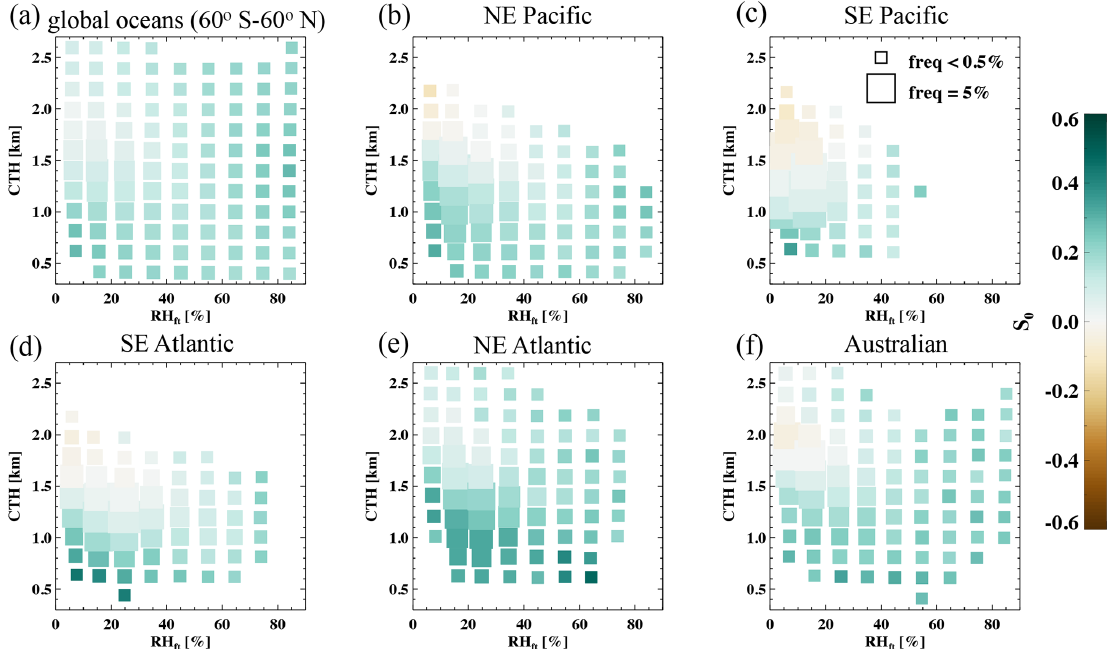
Figure 5. Mean S 0 under different meteorological conditions, namely free-tropospheric relative humidity (RH ft ; x axis) and cloud-top height (CTH; y axis; a proxy for the marine boundary layer depth), for (a) global oceans (60 ◦ S–60 ◦ N) and (b) NE Pacific, (c) SE Pacific, (d) SE Atlantic, (e) NE Atlantic, and (f) Australian stratocumulus regions. Bin sizes for CTH and RH ft are 0.2km and 10%, respectively. The size of the square indicates the frequency of occurrence of a meteorological state. Bins with less than 0.1% frequency of occurrence (or fewer than 100 samples) are not shown.